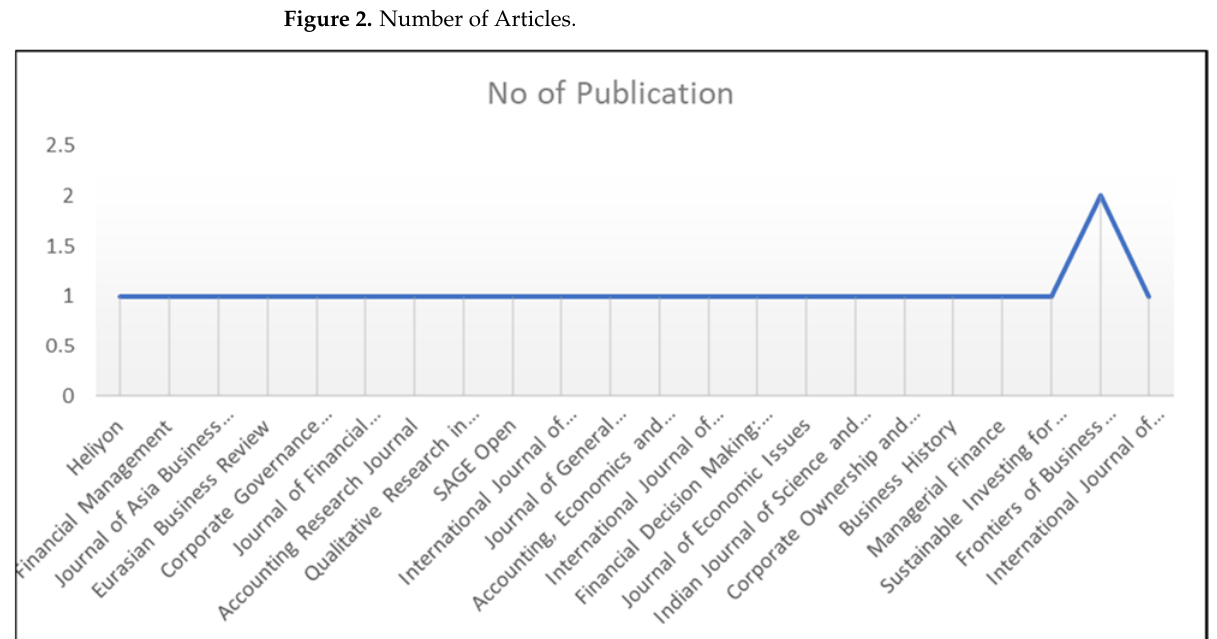
Figure 3. Top Leading Journals.